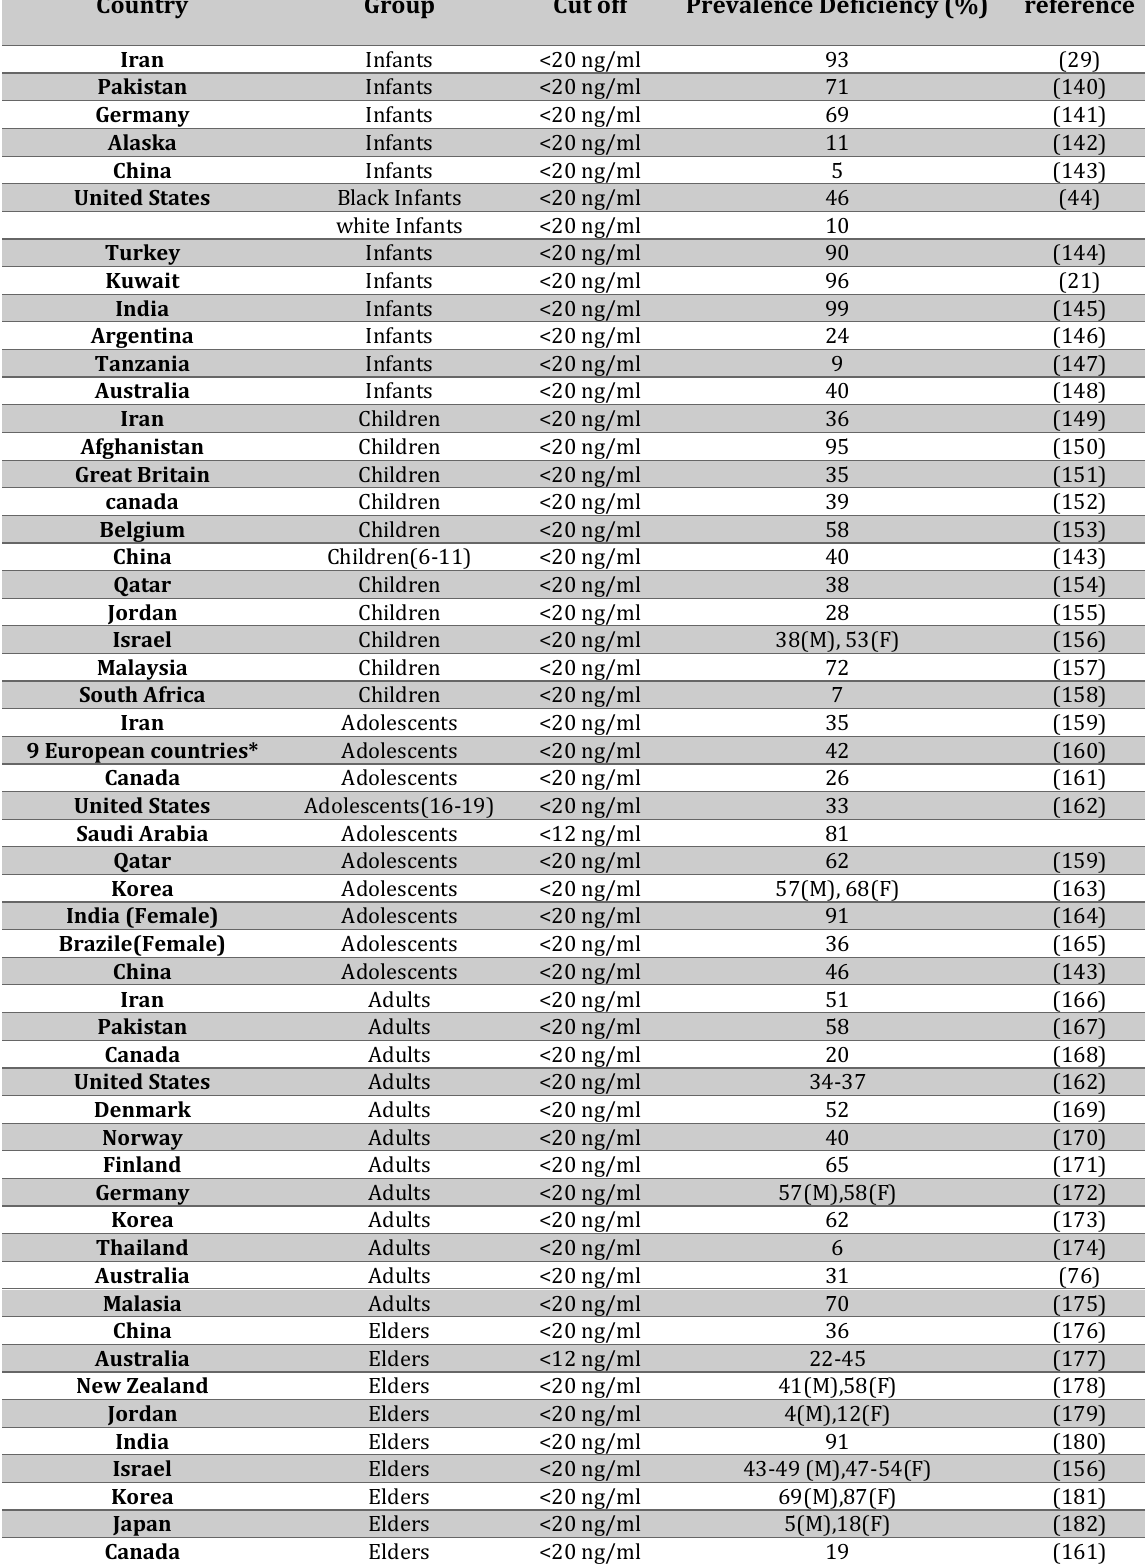
Table 6. Prevalence of moderate vitamin D deficiency worldwide.